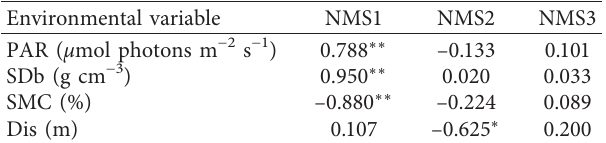
Table 4: Spearman’s rank correlations between the physical factors of photosynthetically active radiation (PAR), soil moisture content (SMC), and soil bulk density (SDb), and distance from the edge to the forest interior (Dis), and nonmetric multidimensional scaling (NMS) ordination axes for mature trees along the edge-interior gradients of both dry deciduous forest and mixed deciduous forest edge sites in the Mae Khum Mee subwatershed.